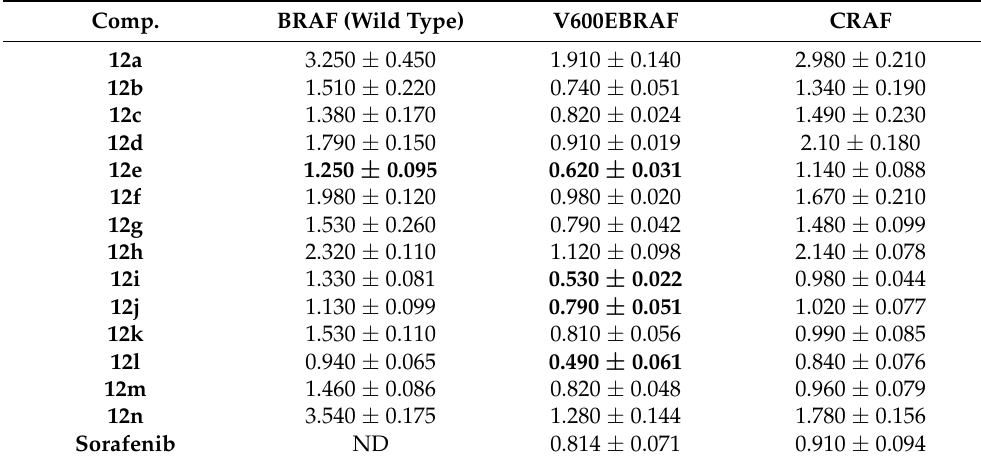
Table 3. IC 50 ( µ M) 1 of the target compounds 12a–n over BRAF (wild-type), V600EBRAF and CRAF.